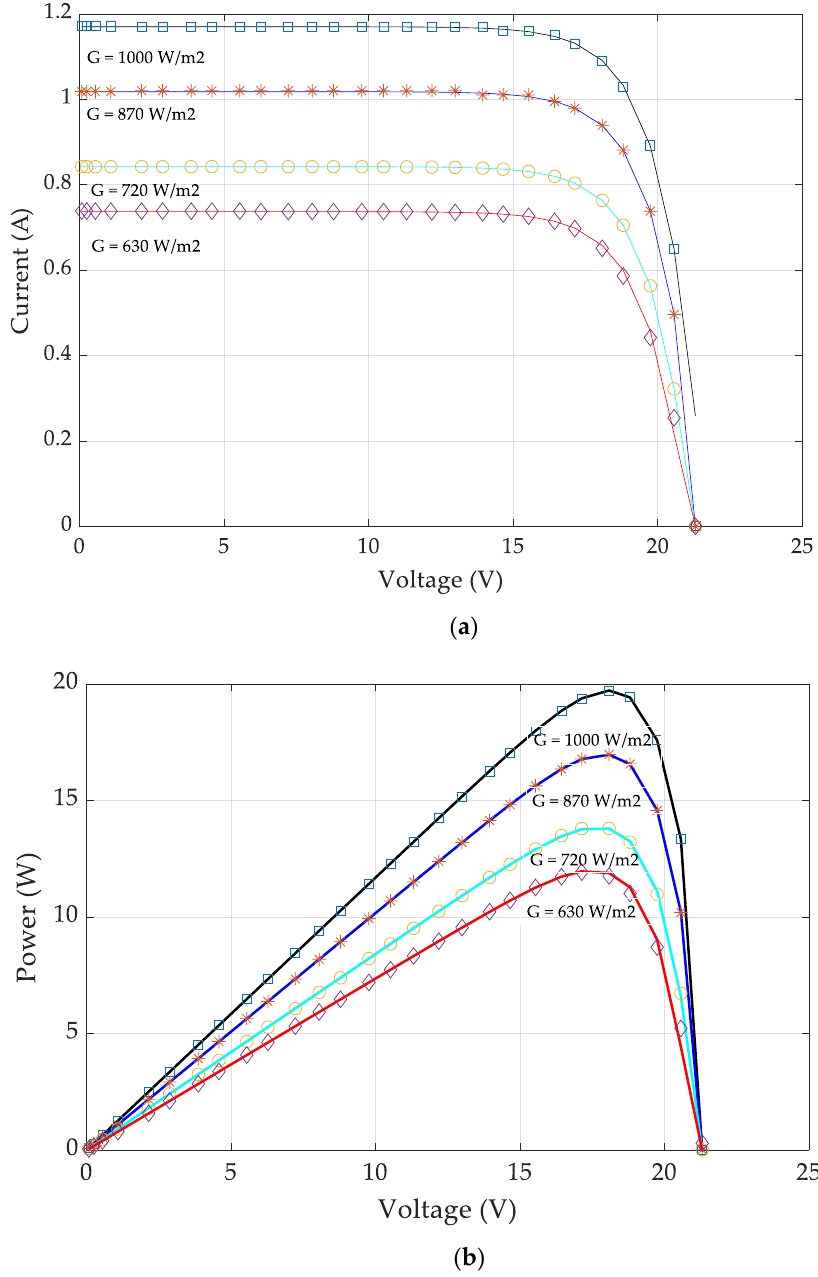
Figure 5. Characteristics curve of simulated and experimental values at different level of irradiance ( a ) I-V curve and ( b ) P-V curve for single-diode model of SS2018P PV module. Symbols represent the estimated data while the solid lines represent the measured data.